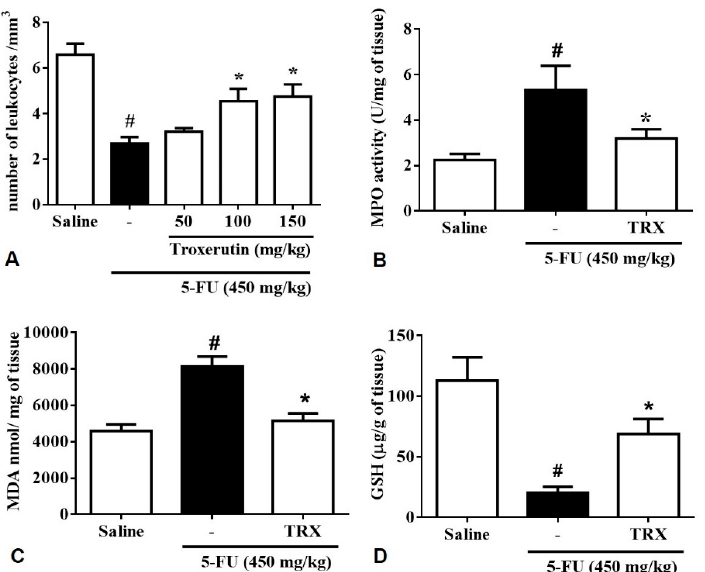
Figure 4. ( A ) Total leukocyte count; ( B ) Activity of myeloperoxidase (MPO); ( C ) Level of malondialdehyde (MDA); ( D ) concentration of glutathione (GSH). For evaluations of MPO, MDA, and GSH, the dose of TRX used 100 mg / kg. Values were presented as mean ± SEM. For the statistical analysis, one-way ANOVA followed by Tukey’s test was used, where # p < 0.05 vs. saline group and * p < 0.05 vs. group 5-FU.